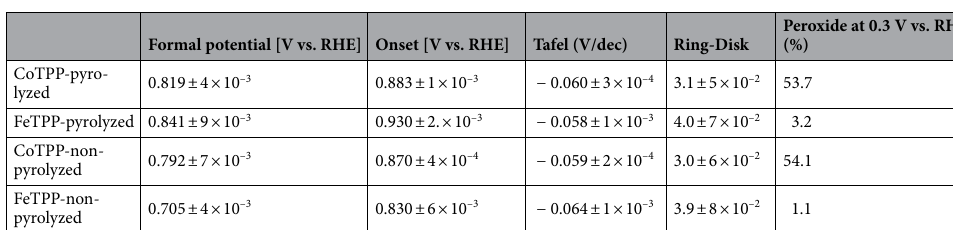
Figure 4. Cyclic voltammetry at 100 mV s −1 in N 2 saturated atmosphere (black line) and polarization curve i L corrected [( i L* i )/( i L -i )] in O 2 saturated atmosphere (red line) with 0.1 M NaOH as electrolytic solution for (a) FeTPP, FeTPP-800 °C, and Vulcan XC-72 (b) CoTPP, CoTPP-800 °C, and Vulcan XC-72. (c) Ring-disk current curves for linear sweep voltammetry at 5 mV s −1 in 0.1 M NaOH O 2 saturated atmosphere for FeTPP or CoTPP at 25(dash line) and after pyrolysis at 800 °C (CoTPP-800 °C, FeTPP-800 °C, solid line), and commercial Pt/C 20 wt% (gray dash line) as from Fig. S5. (d) Tafel plot for the ORR for FeTPP and CoTPP before and after pyrolysis at 800 °C.